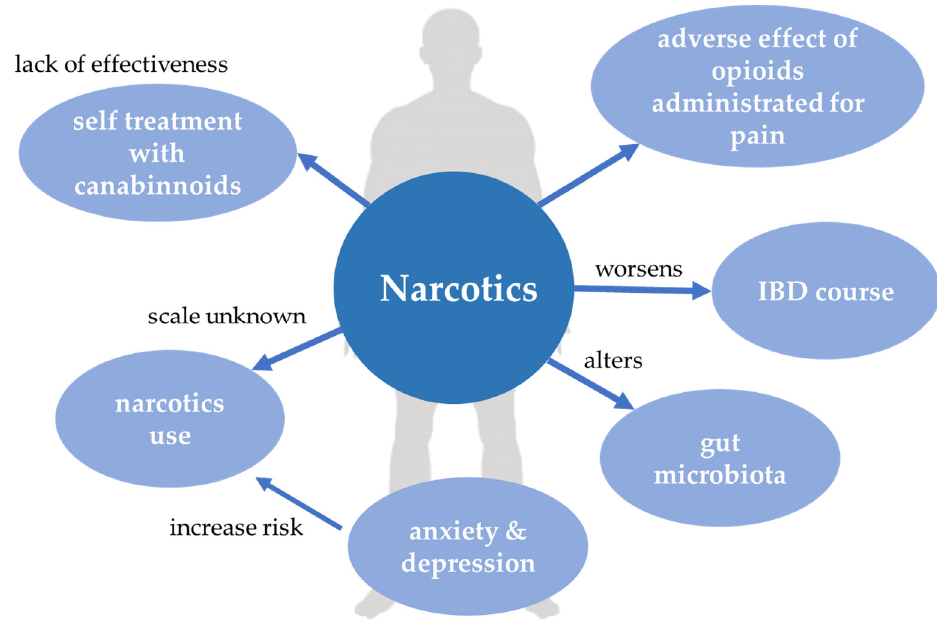
Figure 4. Narcotics and inflammatory bowel disease. IBD, inflammatory bowel disease.